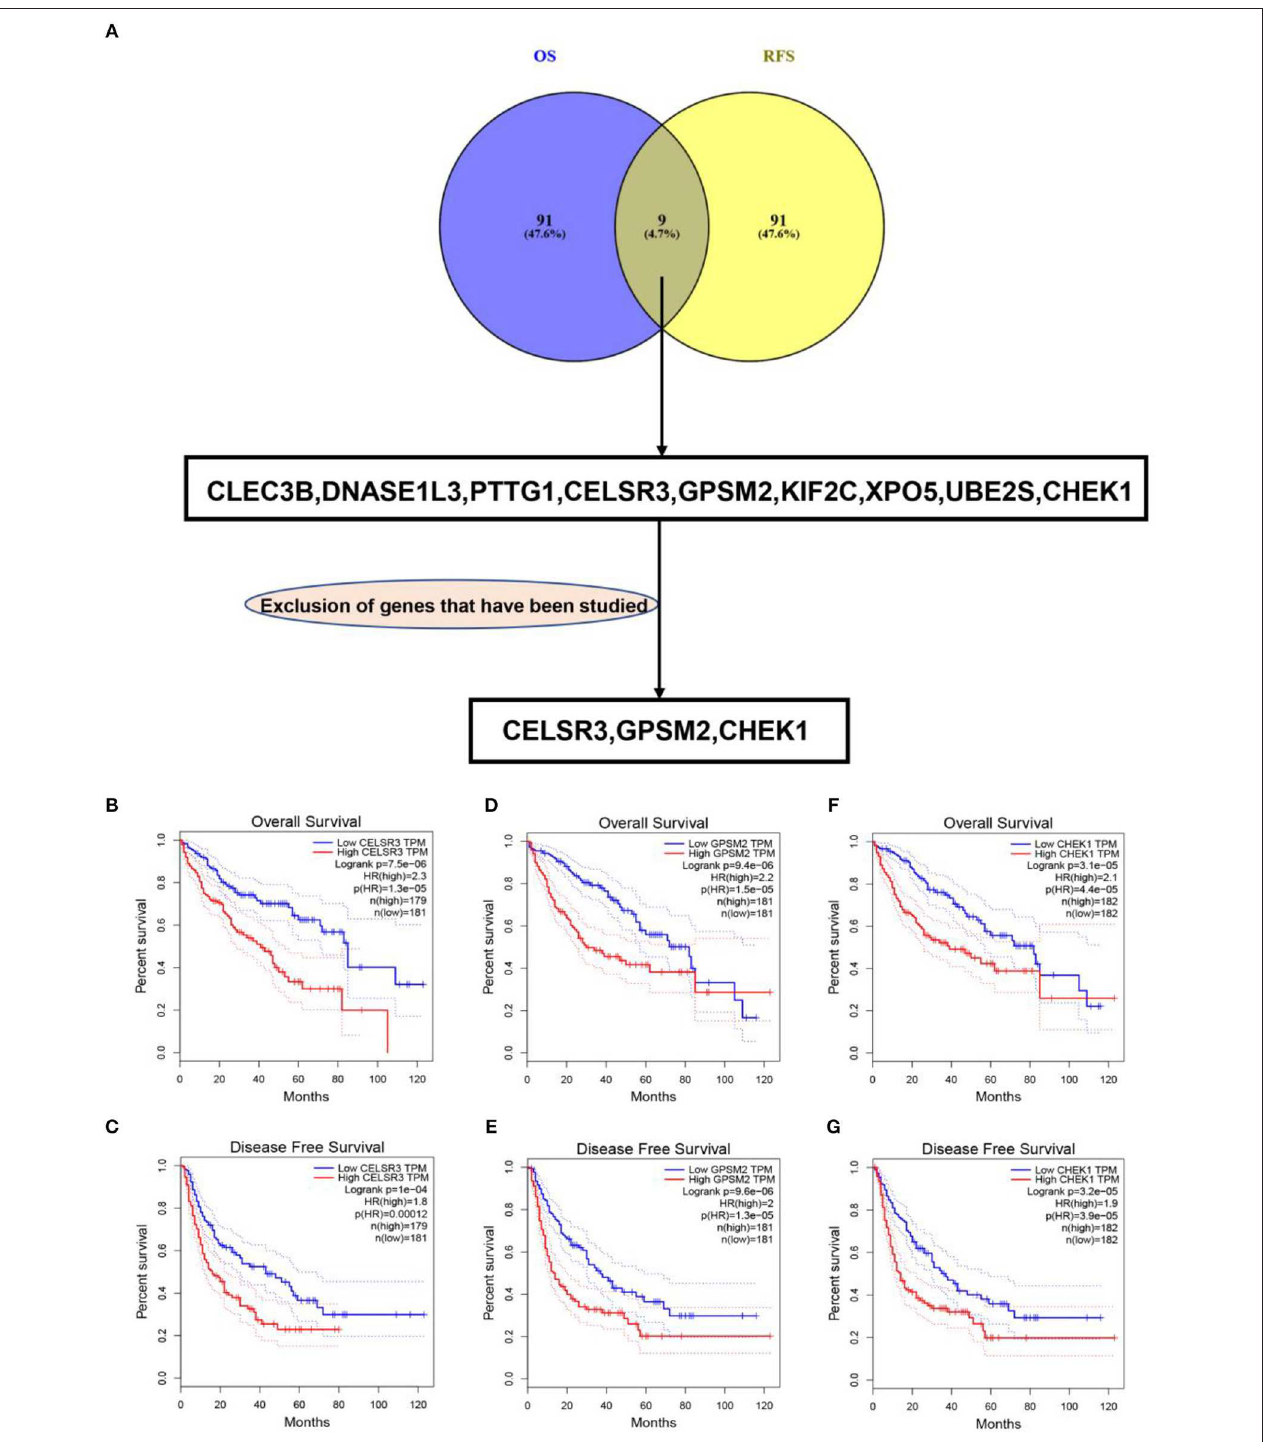
FIGURE 1 | Identification of novel genes significantly associated with prognosis of hepatocellular carcinoma. (A) Identification of CELSR3, GPSM2, and CHEK1 as three novel genes linked to prognosis of hepatocellular carcinoma by intersecting the genes significantly associated with overall survival (OS) and disease-free survival (RFS) and excluding those genes previously studied; high expression of CELSR3 indicated poor OS (B) and RFS (C) of hepatocellular carcinoma; high expression of GPSM2 indicated poor OS (D) and RFS (E) of hepatocellular carcinoma; high expression of CHEK1 indicated poor OS (F) and RFS (G) of hepatocellular carcinoma. Logrank P < 0.05 was considered as statistically